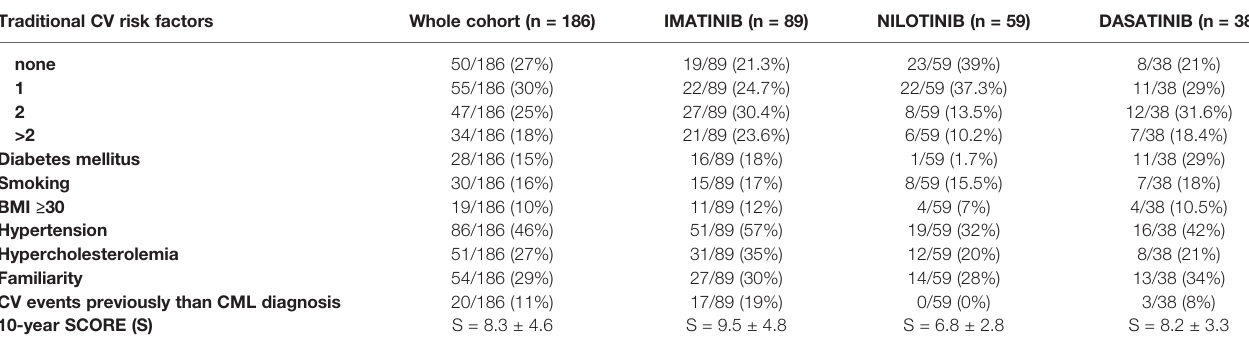
TABLE 2 | Traditional CV risk factors at